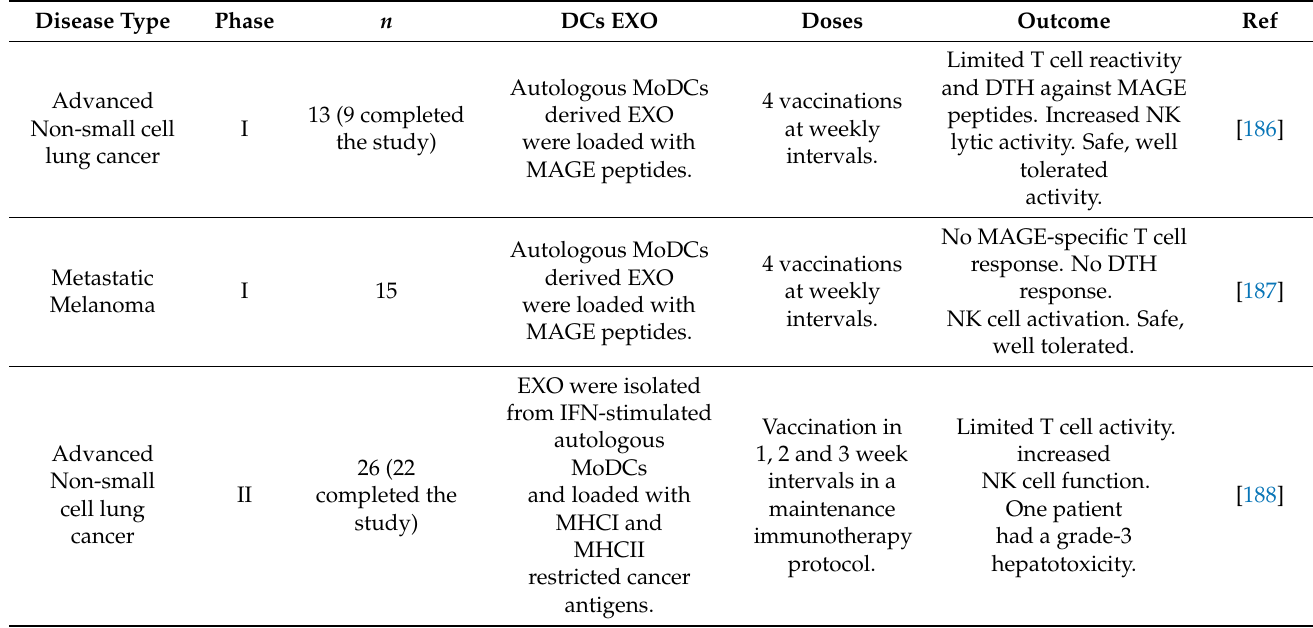
Table 1. DC EXO Clinical